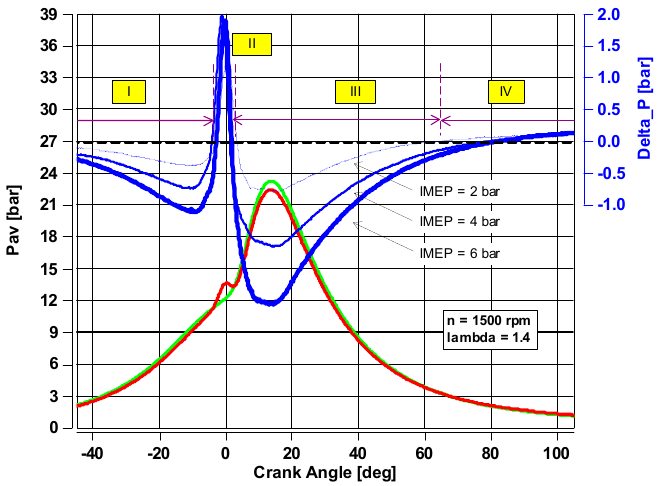
Figure 8. Analysis of pressure changes in combustion chambers: the inter-chamber flows (red line—cylinder pressure; green line—prechamber pressure).